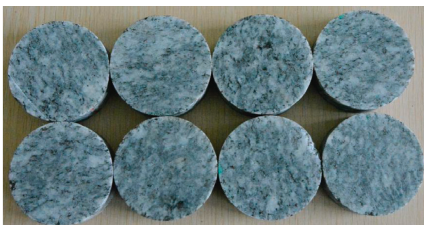
Figure 1: Partial specimens under dynamic compression (diameter- to-height ratio 2:1).